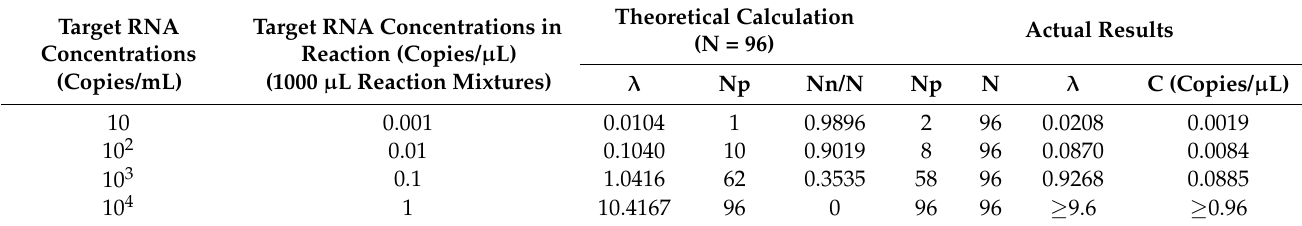
Table 2. The accuracy of the bioluminescent signal-based simulated digital LAMP assay. Target RNA